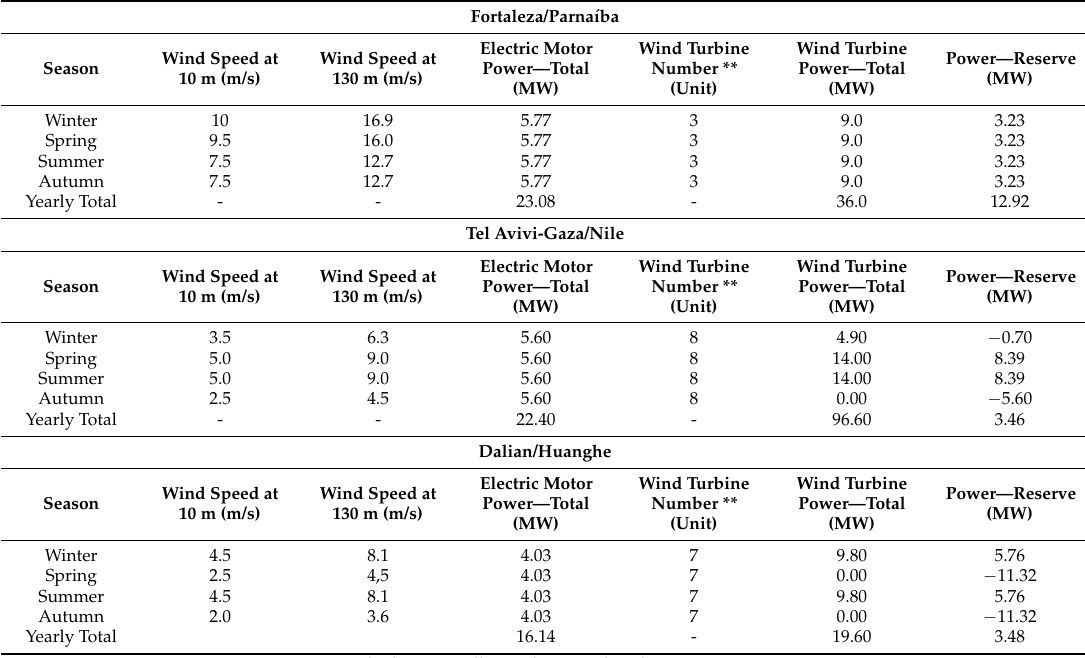
Table 14. Dimensioning of Wind Farms for pipelines. Scenario 2 (81